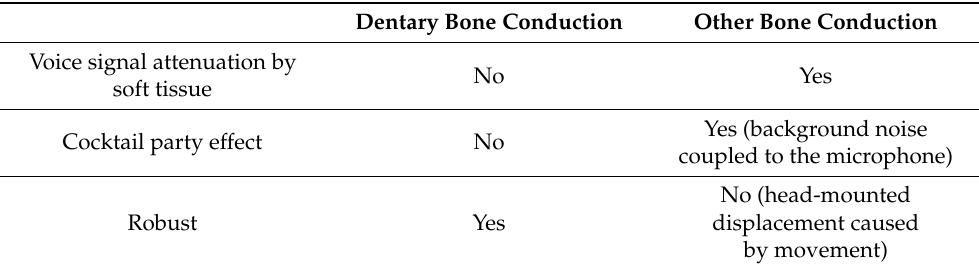
Table 2. The performance comparison between our dentary bone conduction device and other bone conduction devices.